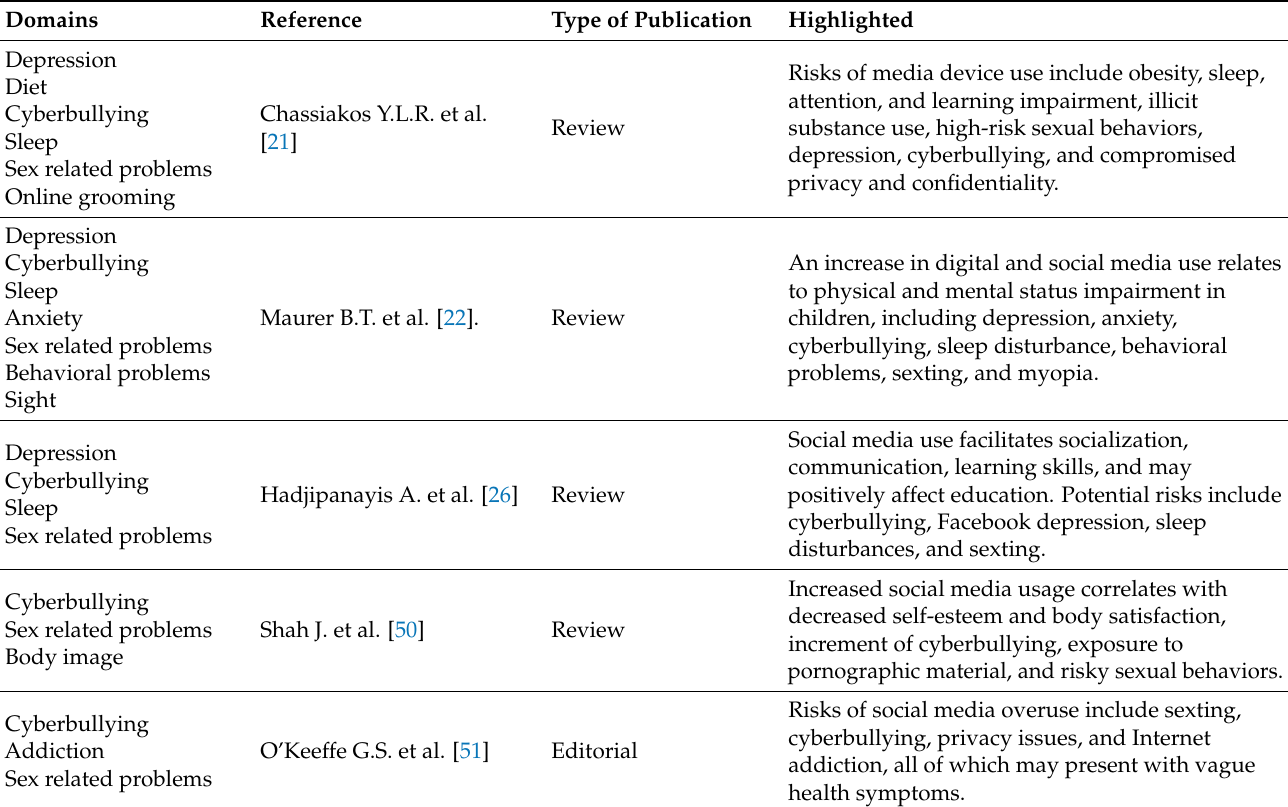
Table 9. Social media and sex related